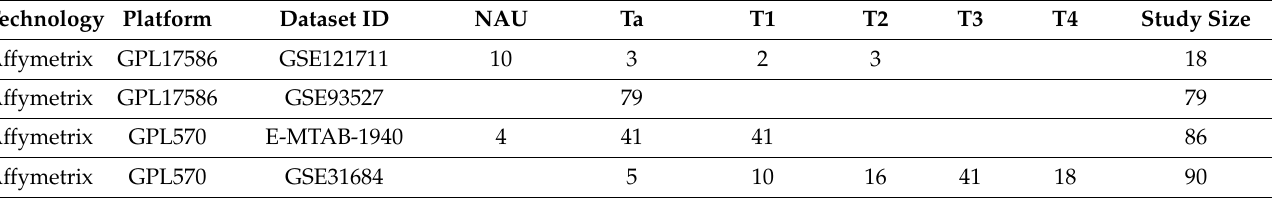
Table A1. Stage distribution across the 12 microarray datasets used for the discovery set. Technology